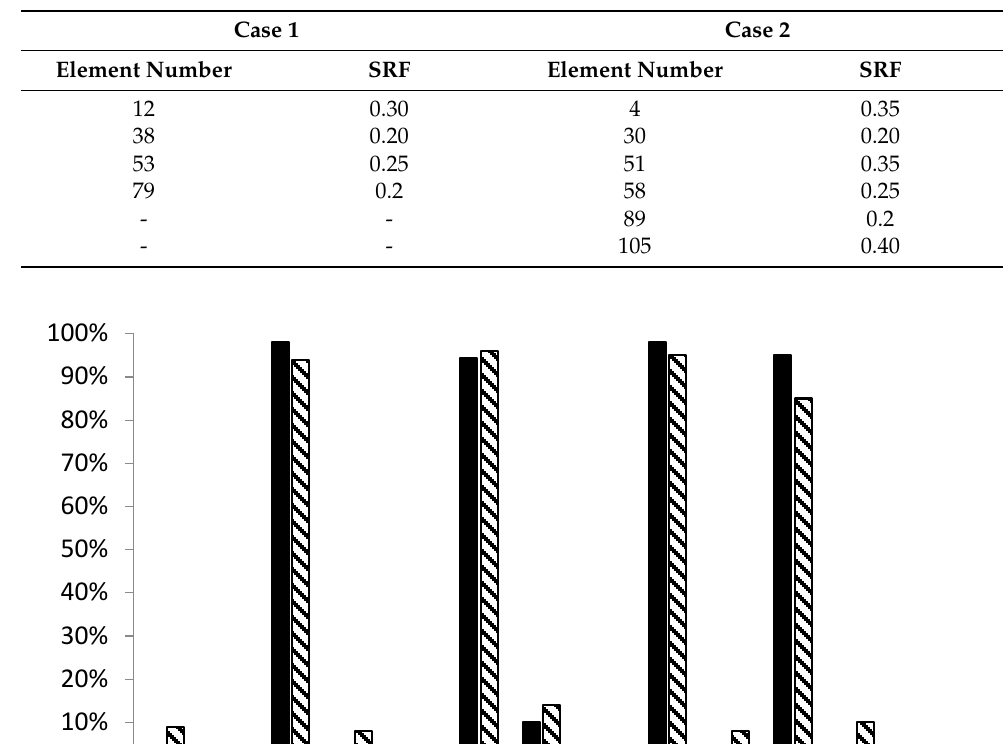
Table 7. Damage scenarios for the 120-bar dome truss.